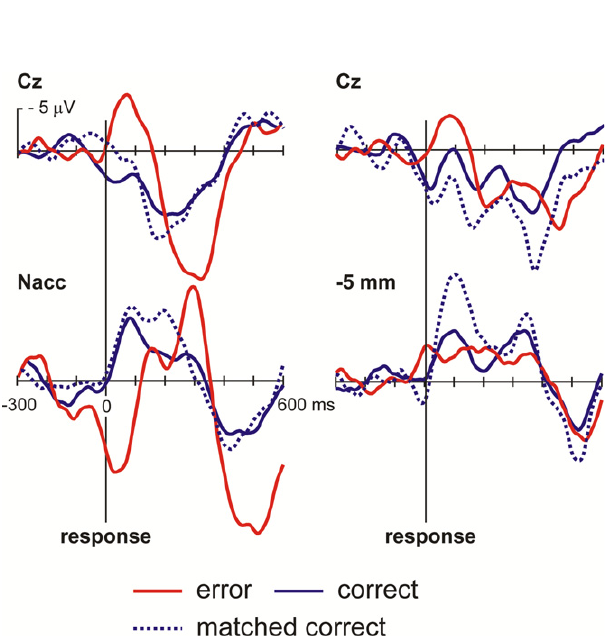
Figure 4. OCD patient. Intraoperative recordings. Shown are averaged ERPs from the surface (Cz – A1) and from the depth electrode within the Nacc or 5 mm above the target. Button press errors (25% of trials) show a typical error-related negativity with a maximum at about 70 ms at Cz. By contrast correct trials show a positive defl ection. Clearly, activity from the Nacc proper but not from the region 5 mm above the target shows error-related modula- tions. To rule out the possibility that differences in brain responses are due to differences in reaction times in error and correct trials, correct trials matched to the error trials with regard to RT are also shown.